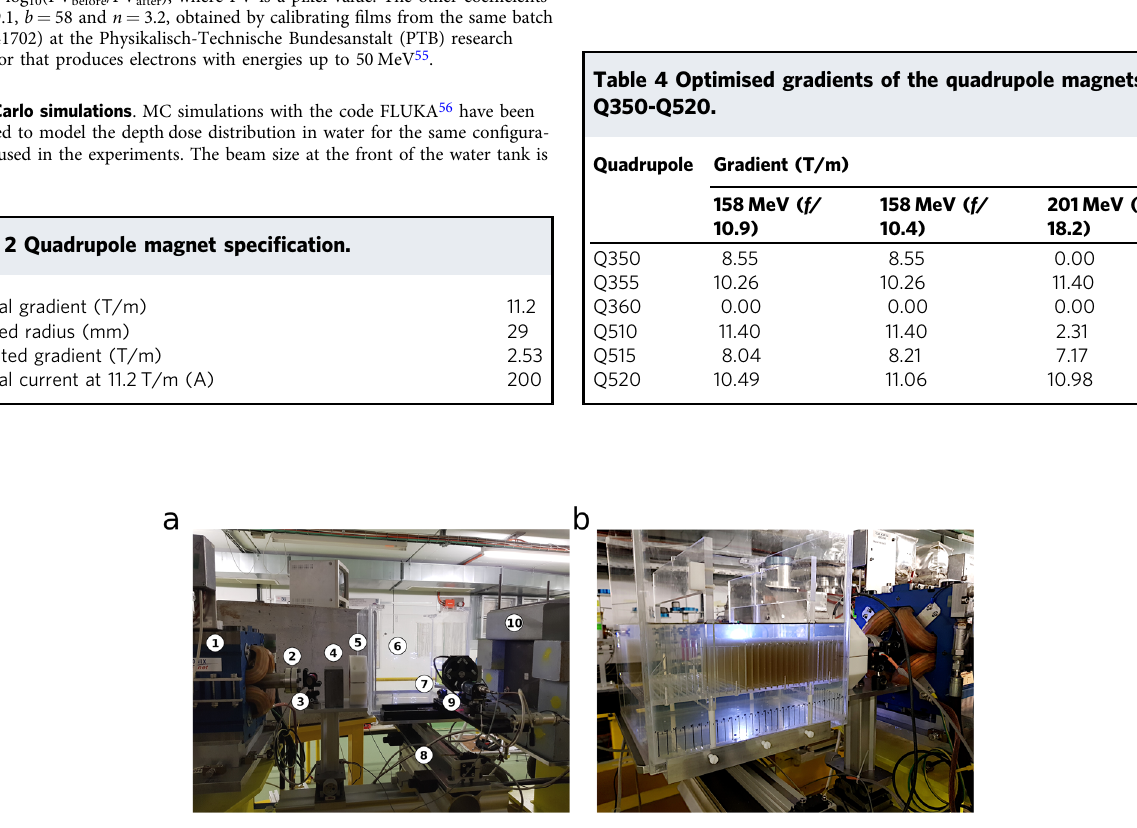
Fig. 5 Experimental setup. Experimental setup ( a ) and EBT3 stack in the custom made holder ( b ). (1) focusing magnet, (2) vacuum window, (3) laser for beam alignment, (4) lead collimator, which was not used during irradiation, (5) ICT for charge measurement, (6) PMMA tank, (7) OTR screen, (8) motorised translation stage for transverse displacements of the PMMA tank, (9) CCD camera, (10) beam